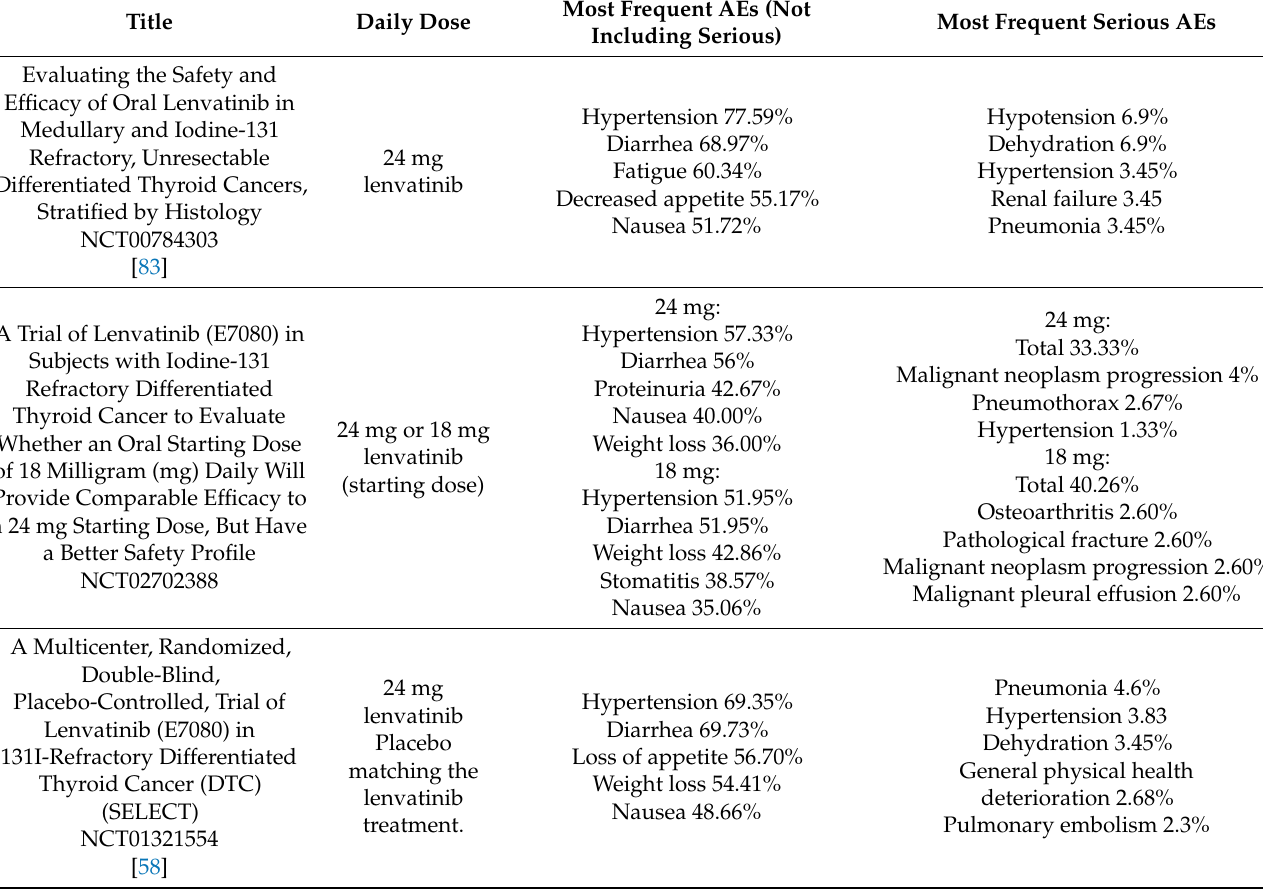
Table 4. Overview of top 5 adverse effects found in clinical trials of lenvatinib, cabozantinib, and sorafenib in